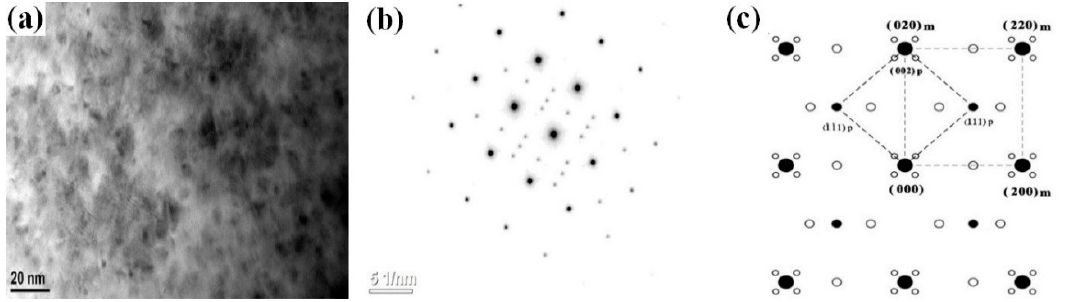
Figure 4. TEM of the S1 alloy aged at 500 °C for 1 hour with a zone axis of [001] Cu ( a ) Bright-image. ( b ) SADP. ( c ) Illustration of SADP.